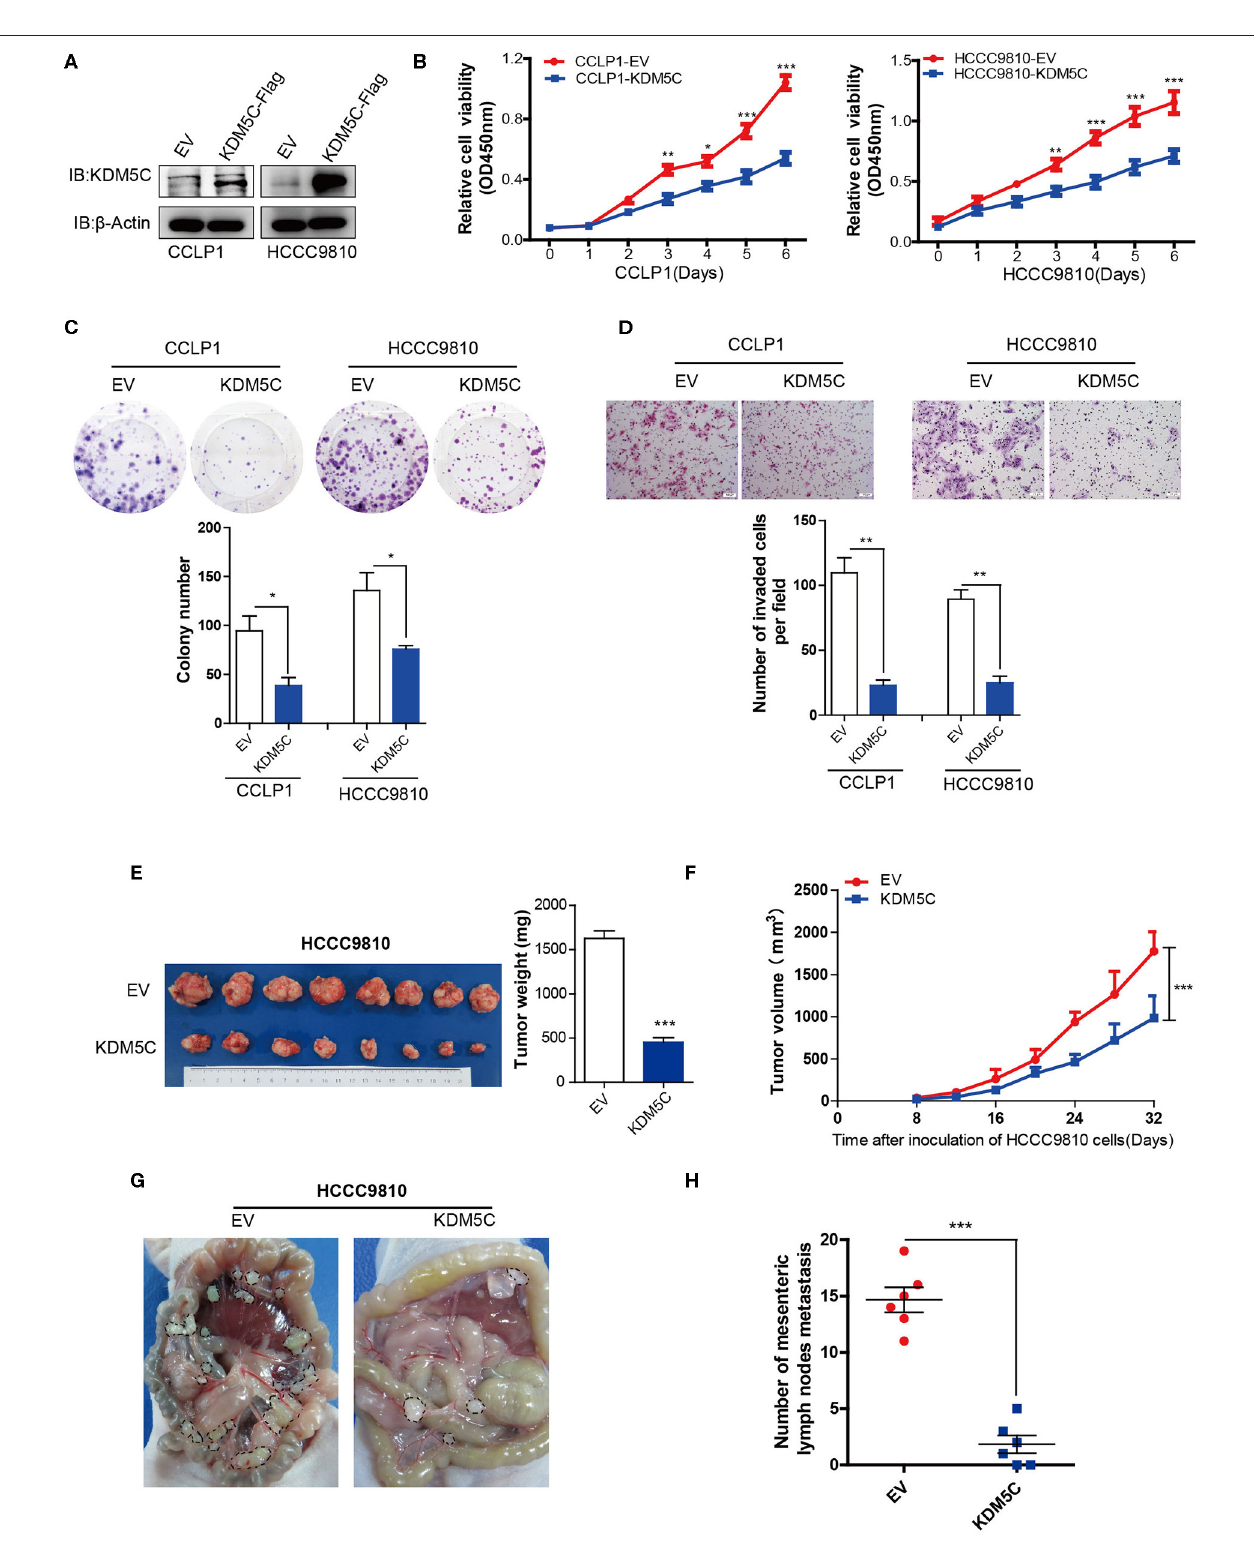
FIGURE 2 | Overexpression of KDM5C inhibits ICC growth and metastasis in vitro and in vivo . (A) Western blotting assay of KDM5C protein in CCLP1 and HCCC9810 cells stably transduced with vector control or KDM5C-expressing vector. (B) Cell Counting Kit 8 assay of cell proliferation after KDM5C overexpression in